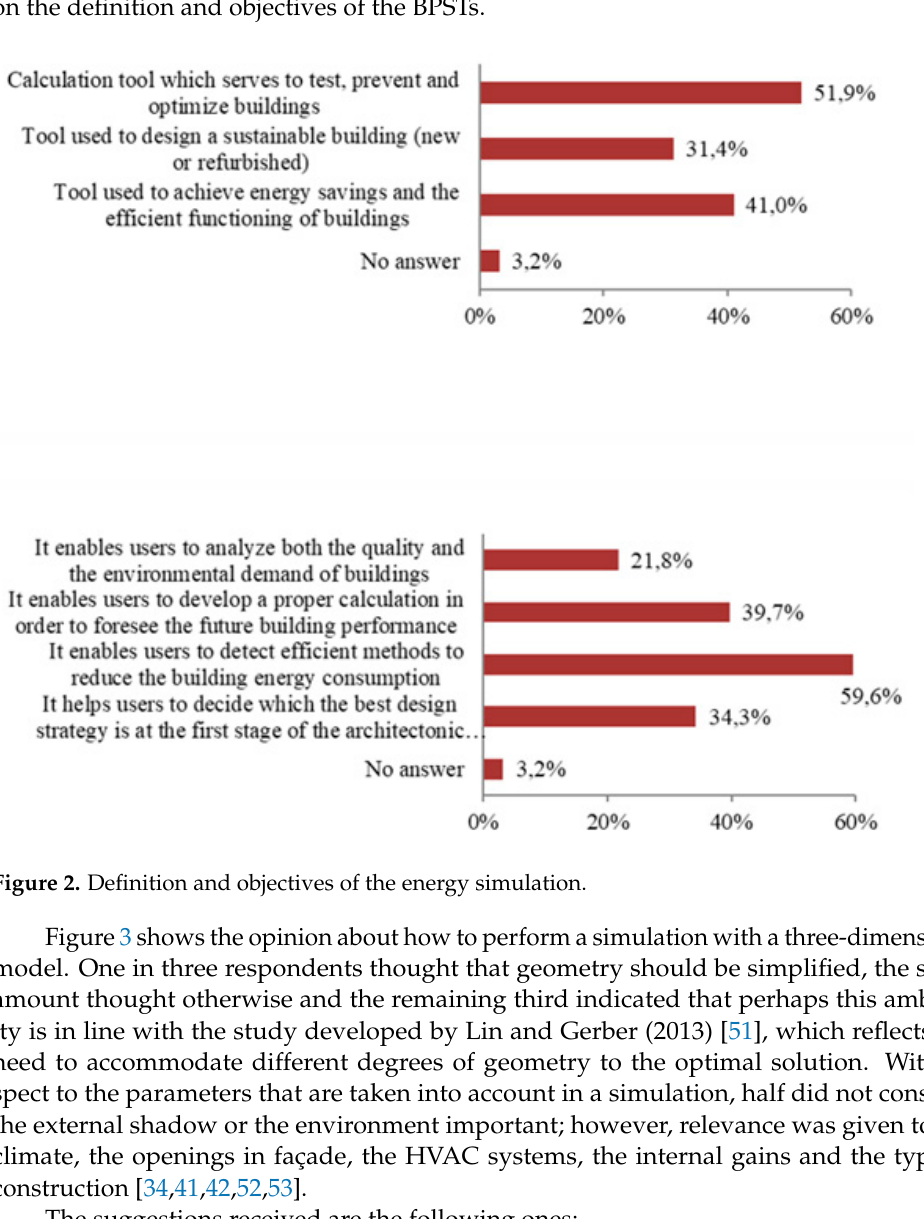
Figure 1. Confidence parameters of architects with professional experience below 5 years.